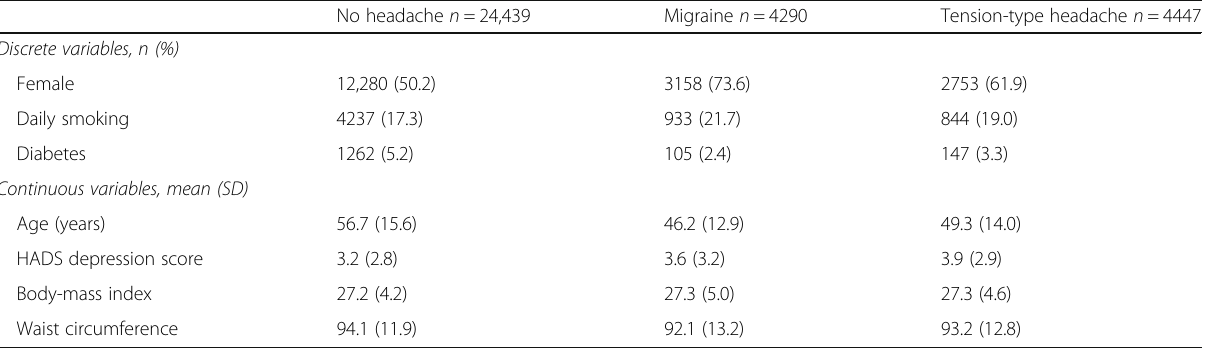
Table 1 Clinical profile of participants